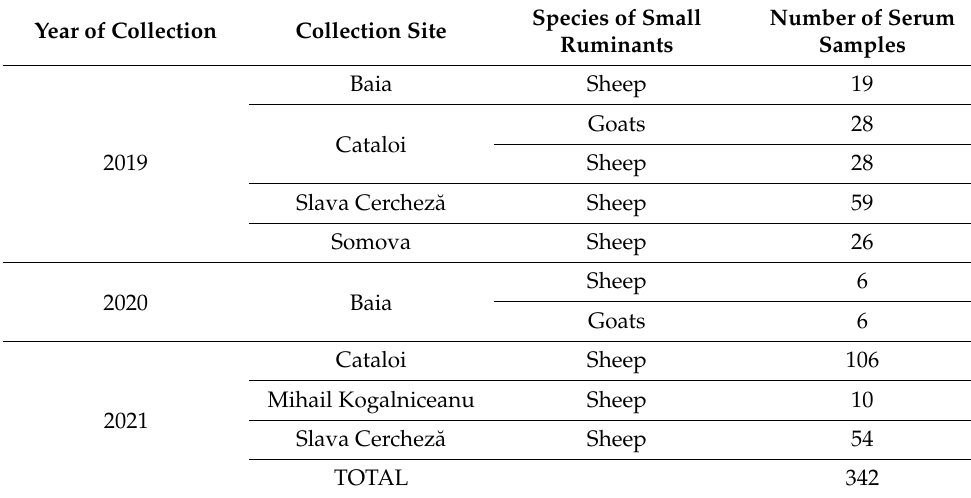
Figure 1. Location of small ruminants and tick specimens collected in the Danube Delta reserve. Table 1. Ruminant serum samples collected from Tulcea County,